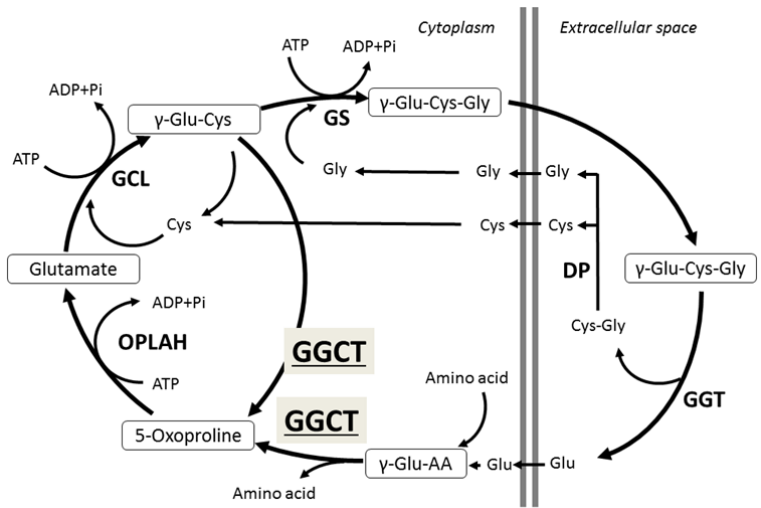
Figure 1. γ-Glutamyl cycle. GGCT, γ-glutamylcyclotransferase; GGT, γ-glutamyltranspeptidase; GCL, Figure 1. γ -Glutamyl cycle. GGCT, γ -glutamylcyclotransferase; GGT, γ -glutamyltranspeptidase; glutamate cysteine ligase; GS, glutathione synthase; OPLAH, 5-oxoprolinase; γ-Glu-Cys-Gly, GCL, glutamate cysteine ligase; GS, glutathione synthase; OPLAH, 5-oxoprolinase; γ -Glu-Cys-Gly, glutathione; DP, dipeptidase. glutathione; DP,